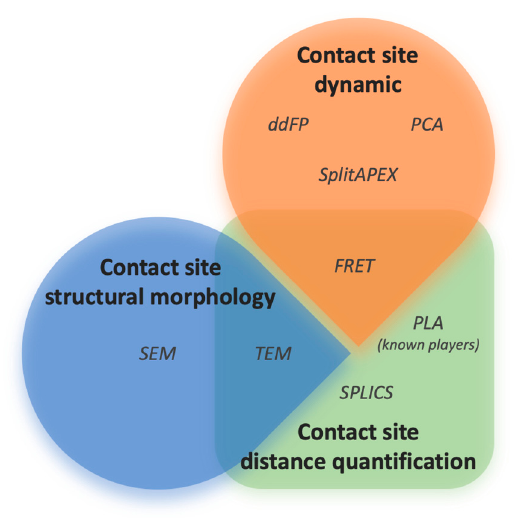
Figure 3. Three main sub-groups of useful methods to characterize ER–mitochondria contact sites have been identified, which provide information on contact site dynamics, contact site distance, and contact site structural morphology. Methods are clustered on the basis of their utility to output a specific information; at intersections, those amenable approaches able to provide more than one information on contact sites have been reported. Abbreviations: ddFP (dimerization-dependent fluorescent protein) [79], PCA (protein-fragment complementation assay) [81], SplitAPEX (split-ascorbate peroxidase) [104], PLA (proximity ligation assay) [100], SPLICS (split-GFP) [89], TEM (transmission electron microscopy) [105], and SEM (scanning electron microscopy) [111].